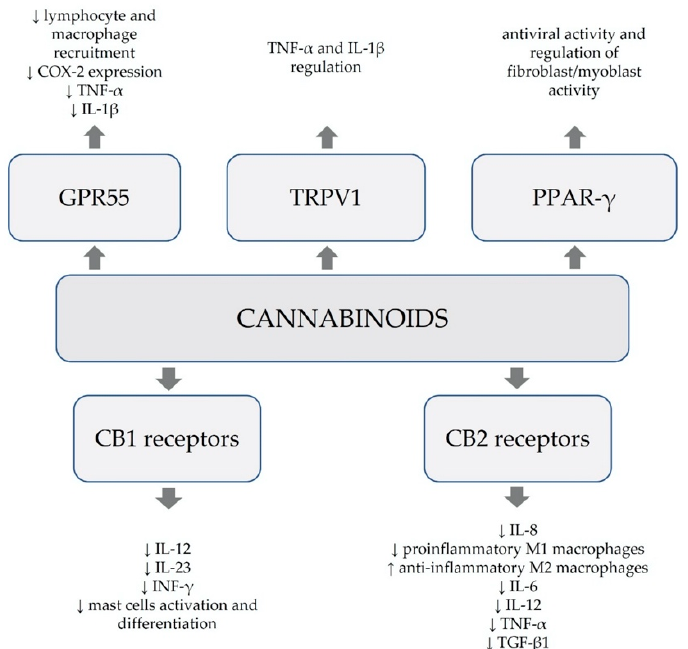
Figure 1. Anti-inflammatory, immunological and antioxidative modes of action of cannabinoids [3]. Endocannabinoid receptors are also activated by exogenous substances, known as phytocannabinoids—extracted from Cannabis sativa L., and other synthetic compounds [8]. Cannabis sativa L. is rich in over 100 discovered phytocannabinoids. The key two include ∆ 9-tetrahydrocannabinol (THC), a compound with psychoactive properties due to its strong affinity to CB1 receptors, and cannabidiol (CBD), which is considered non-psychotropic [8]. Other compounds of Cannabis sativa L. include cannabigerol (CBG), cannabichromene (CBC), tetrahydrocannabivarin (THCV), cannabicitran (CBT) and many others [8,9].